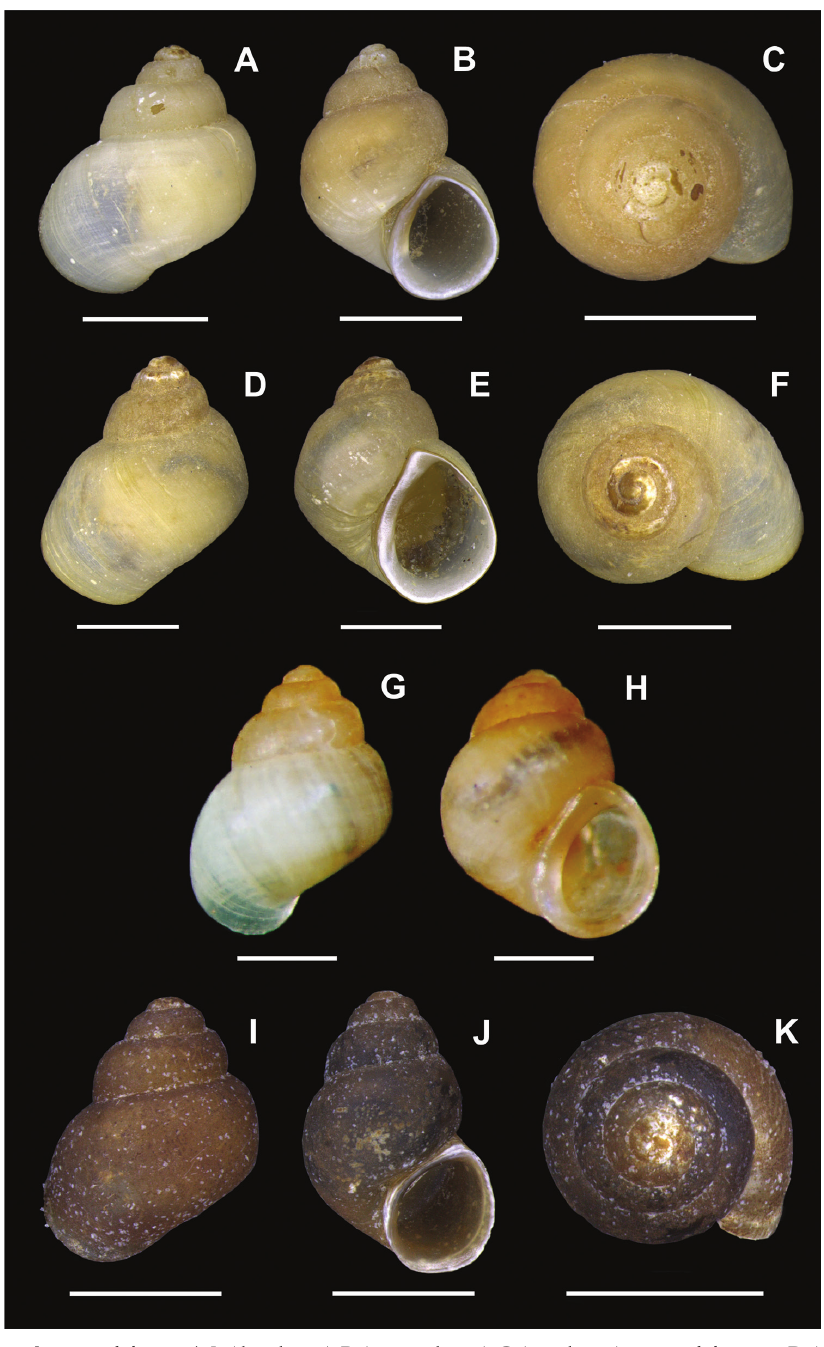
Figure 6. Potamolithus sp. 4 A (dorsal view) B (apertural view) C (apical view); Potamolithus sp. 5 D (dorsal view) E (apertural view) F (apical view); Potamolithus sp. 6 G (dorsal view) H (apertural view); Potamolithus sp. 7 I (dorsal view) J (apertural view) K (apical view). Scale bars: 1 mm. (Photographs: LBR